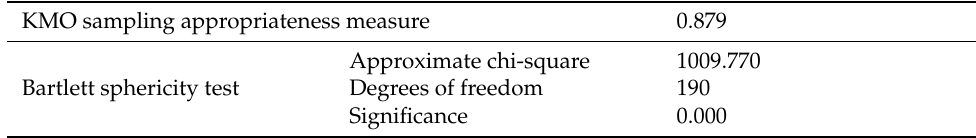
Table 2. Test results of KMO and Bartlett effect